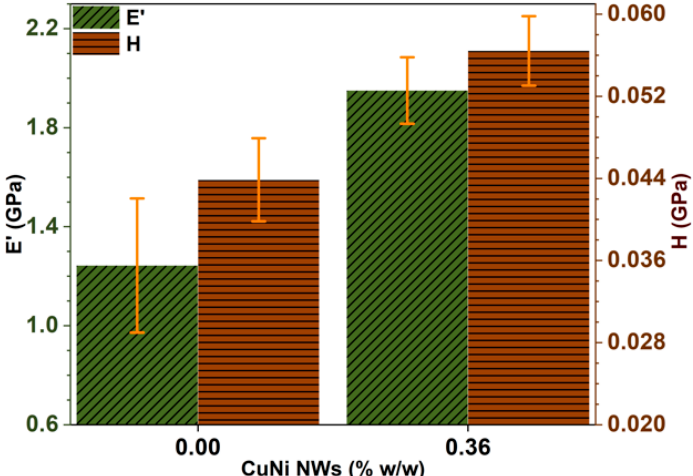
Figure 5. Average values of E (cid:4593) (green) and H (brown) for the pure and CuNi NW-loaded substrates, corresponding to the mappings in Figure 4.